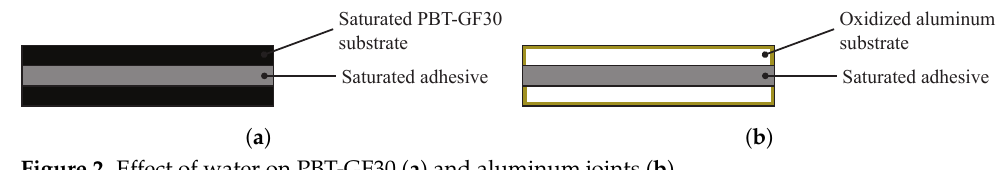
Figure 2. Effect of water on PBT-GF30 ( a ) and aluminum joints ( b